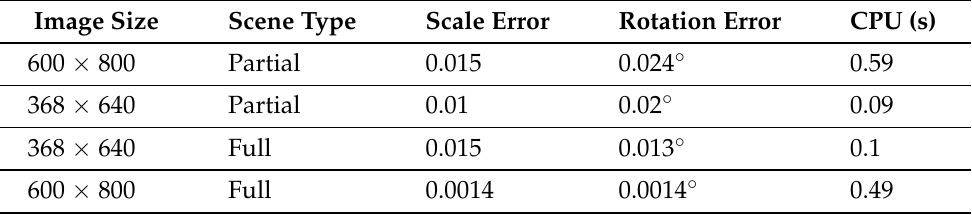
Table 1. Statistical error performance from 100 Monte Carlo runs, where all errors are root mean square